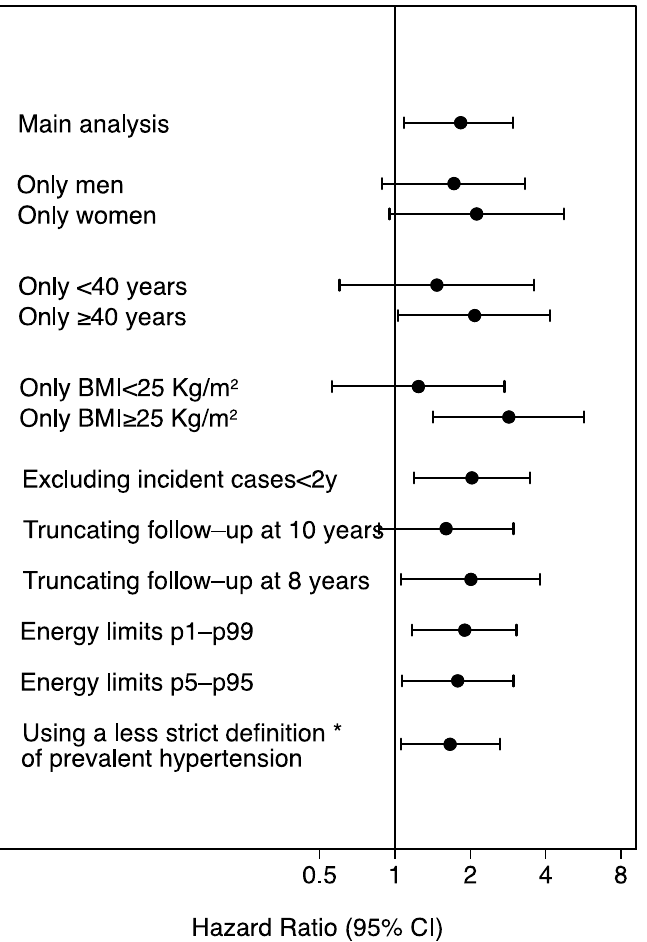
Figure 4. Sensitivity analyses. Hazard ratios (95% confidence interval) of incident hypertension for low (0–1) vs. high adherence (8–9) to the Mediterranean alcohol drinking pattern. The SUN Project 1999–2018. * Including also participants with baseline systolic blood pressure between 130 and 139, or diastolic blood pressure between 80 and 89 mmHg. BMI: body mass index.